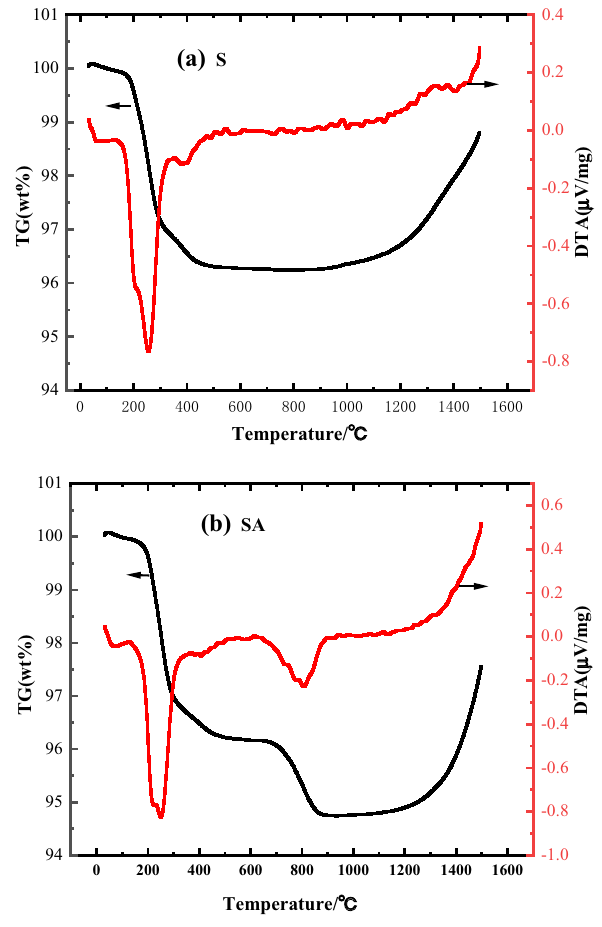
Fig.1 TG-DTA curve of green samples heated in air at a rate